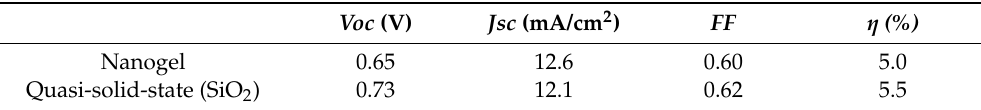
Table 3. Photovoltaic properties of DSSCs based on nanogel and quasi-solid-state (SiO 2 ) electrolytes under 1 sun illumination. (AM 1.5 G, 100 mW/cm 2